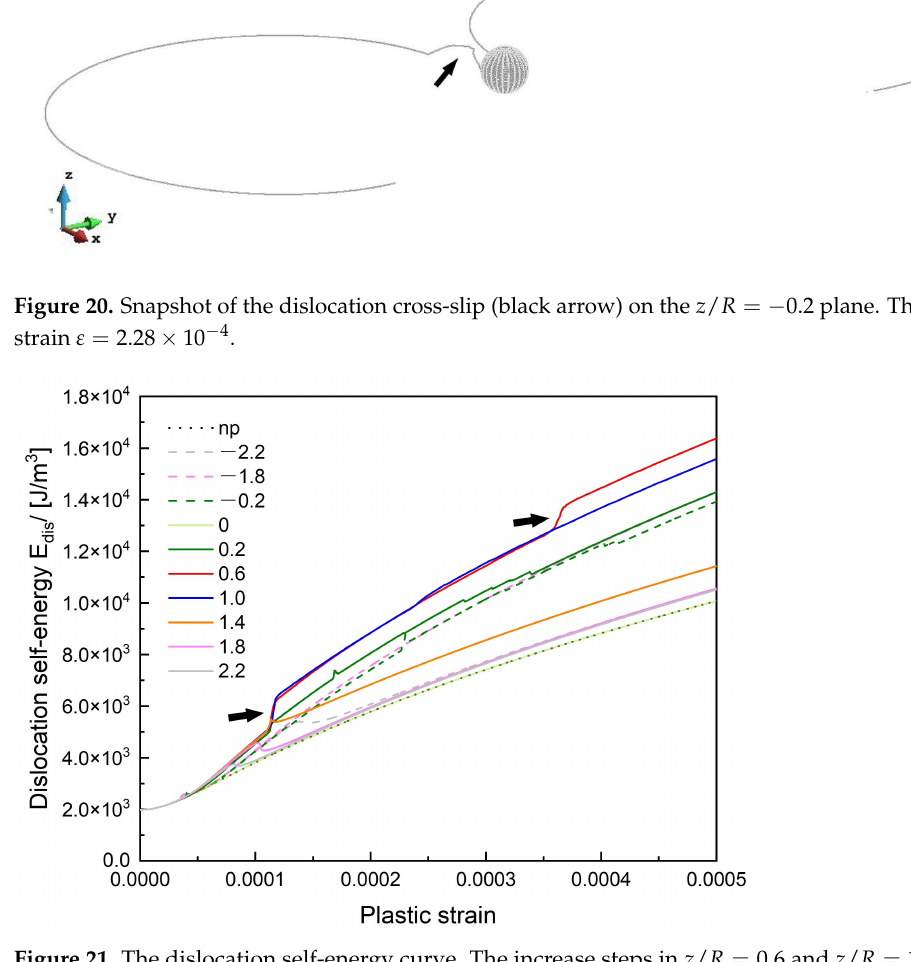
Figure 21. The dislocation self-energy curve. The increase steps in z / R = 0.6 and z / R = 1.0 cases due to a large-scale cross-slip are pointed by black